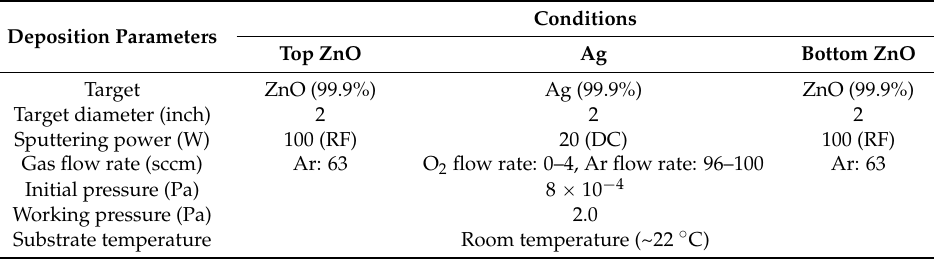
Table 1. Sputtering conditions of ZnO/Ag/ZnO